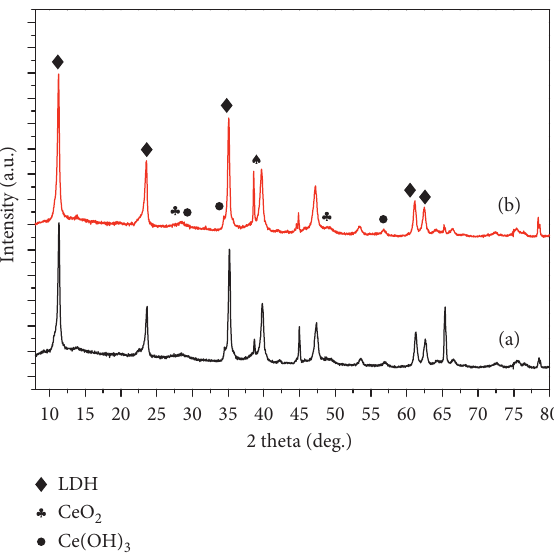
Figure 11: XRD patterns after 1200hrs of immersion in 0.1M NaCl solution: (a) CeLDH-H, (b)